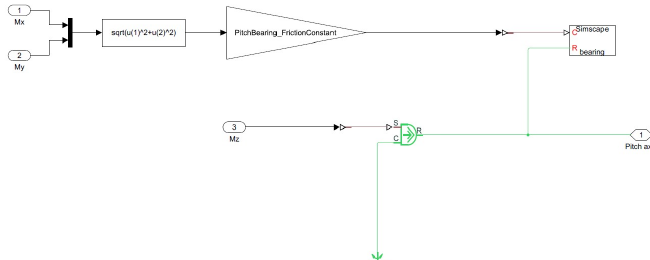
Figure 9. Pitch bearing model.